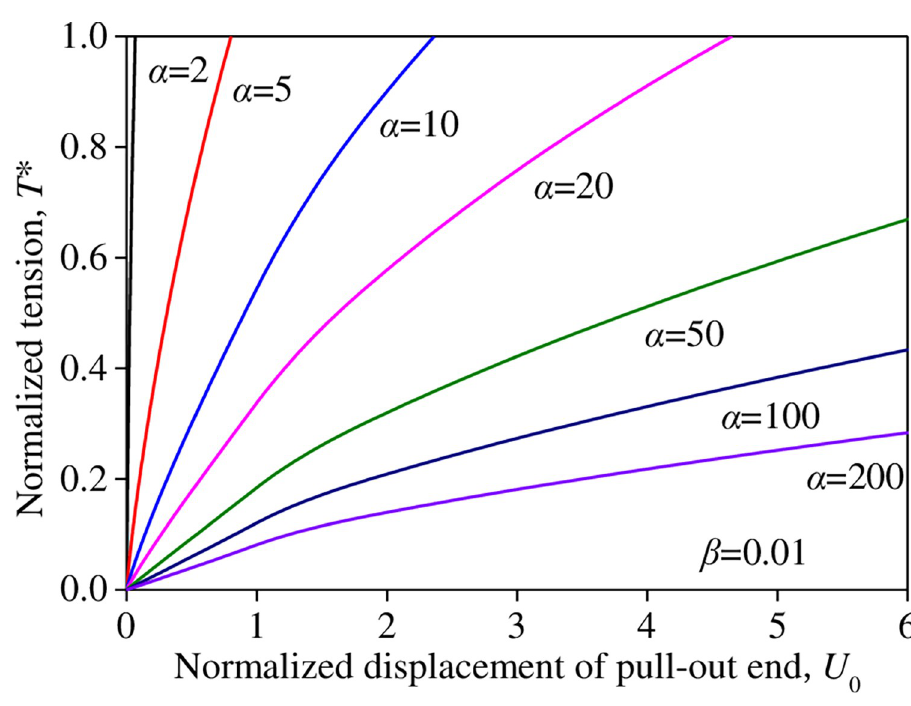
Fig 10. Influence rule of α on the T � –U 0 relation ( β = 0.01).